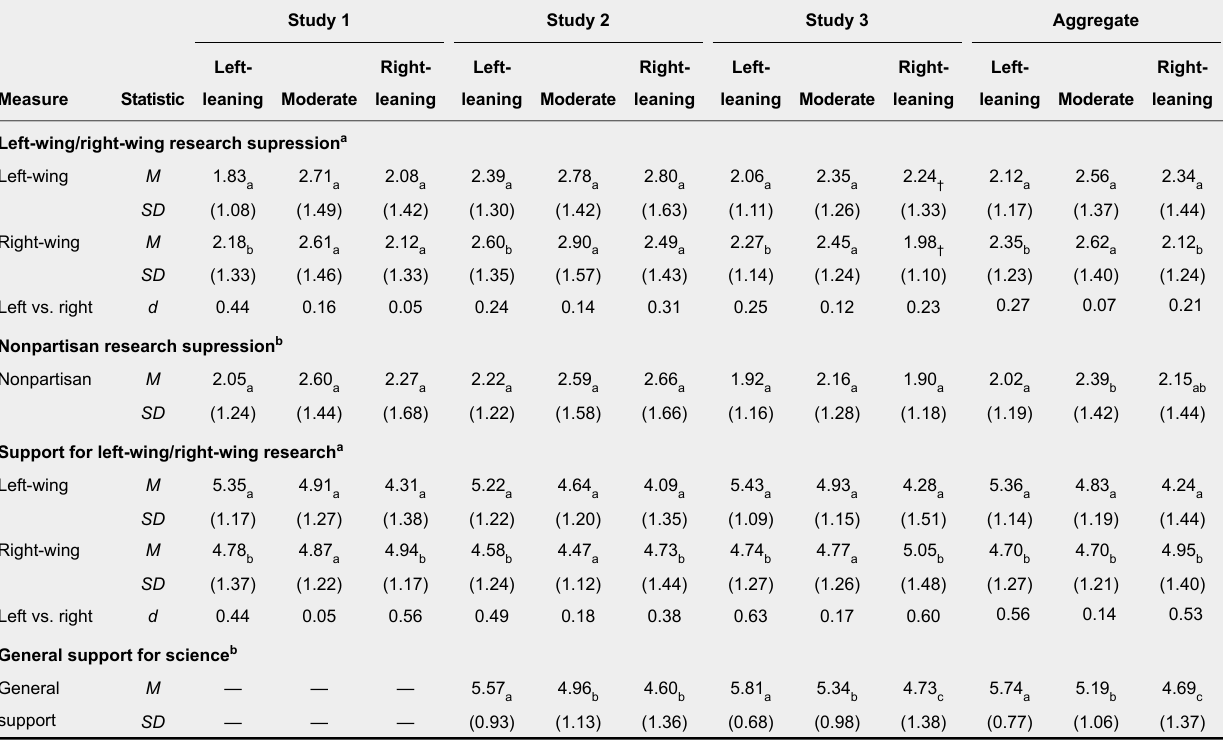
Mean Scores on Measures for Left-Leaning, Moderate, and Right-Leaning